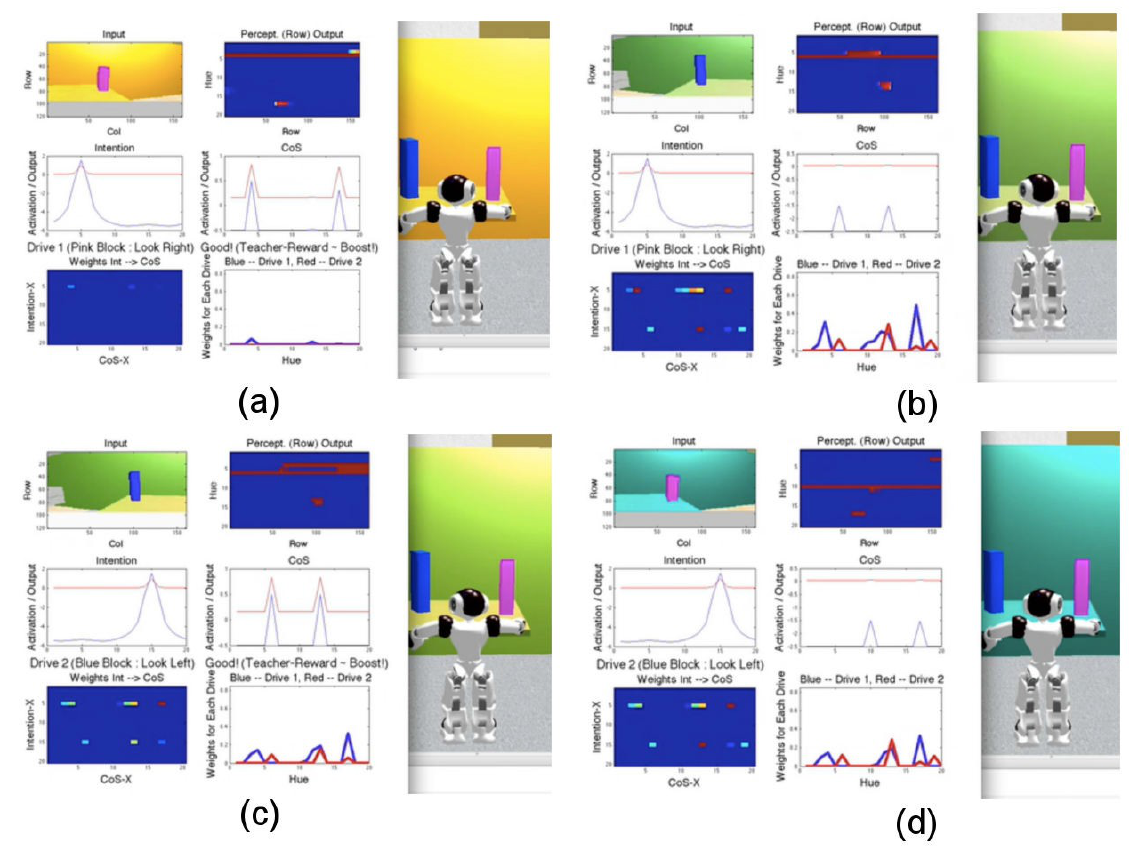
Figure 7: NAO during various stages of learning. With Drive A active, the NAO receives a reward when it finds a pink object as shown in (a), but not when it finds a blue object (b). When the reward is received in (a), weights from the intention to CoS field are boosted not only for the rewarding object color (pink), but incorrectly boosted for the background color as well. When Drive B is active, the NAO only receives a reward for finding a blue object, (c), but not for finding the pink object (d). As before, when a reward is received for finding the block that satiates the active drive, weights are not only boosted for the correct color, but for the incorrect background color as well. After learning over a large number of trials however, only the rewarding color weights remain, with the incorrect weights driven to 0 (shown in Fig. 8)